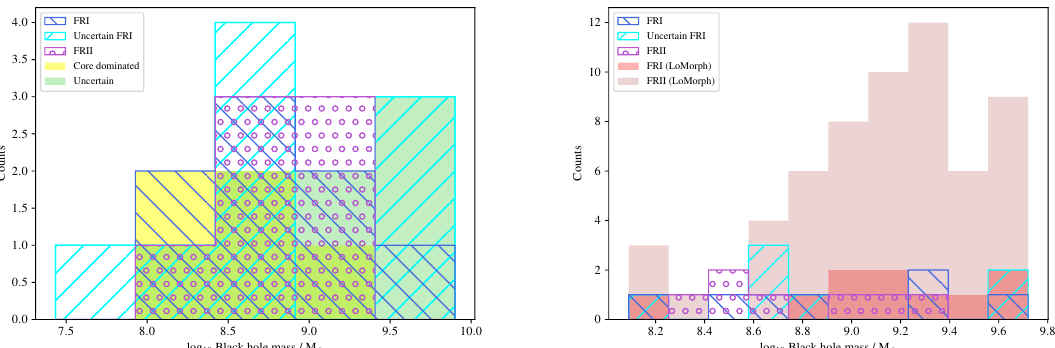
Figure 4. Left-panel : The black hole mass histogram of quasars that were included in the pilot survey with the VLA. Right-panel : The black hole mass histogram of quasars that were classified as FRI, FRII and uncertain FRI as part of our pilot study along with FRI and FRII quasars classified by [11] using LoMorph. For a clean representation, we show FRII quasars and uncertain FRIIs using the same